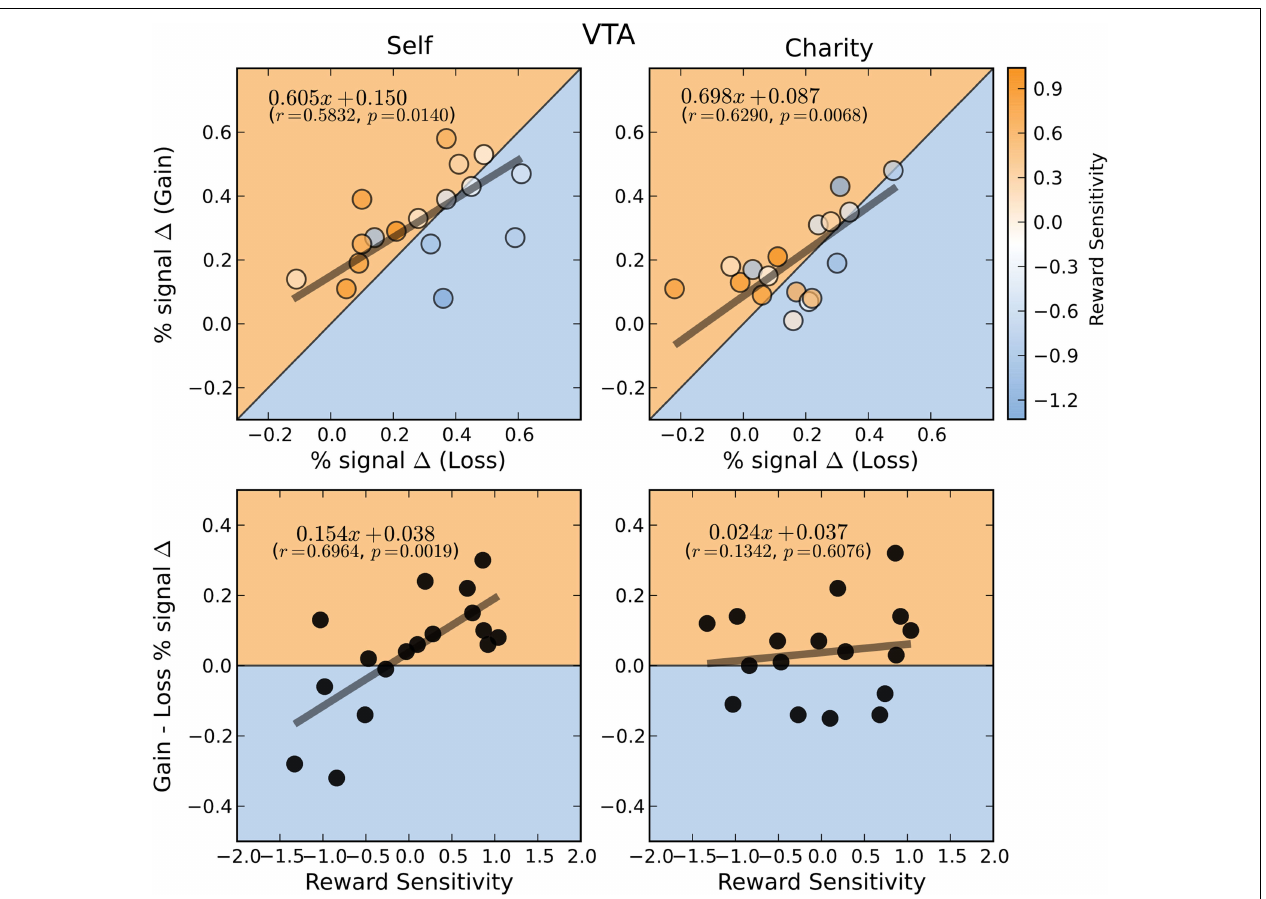
FIGURE 6 | BOLD responses in the VTA during the anticipation of gain and loss are positively correlated whether participants play for themselves or for a charity. Top : Average percent signal change differences (paid-control) for anticipation of gain and loss trials for the Self ( left ) and Charity ( right ) treatments. Each point is colored according to the participant’s relative reward sensitivity index (z transformed). Gain and loss responses differences are